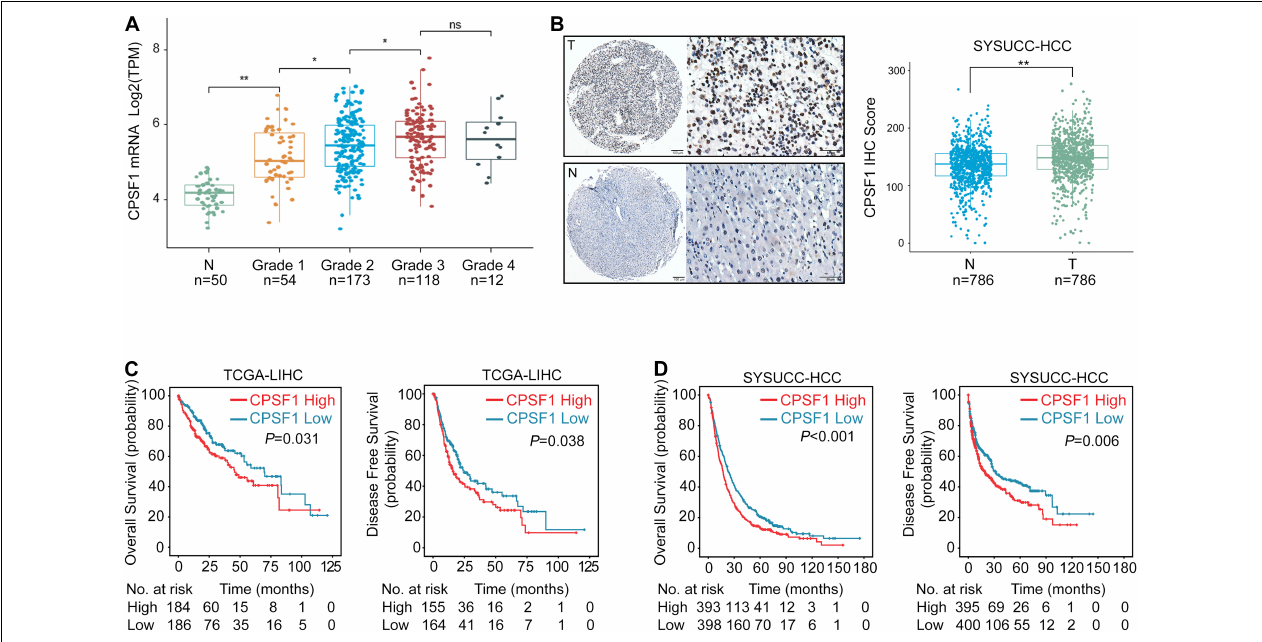
FIGURE 2 | Increased CPSF1 in HCC correlates with unfavorable patient outcome. (A) CPSF1 expression was evaluated in TCGA LIHC samples according to different tumor grades. Two-way ANOVA tests showed statistically significant difference between groups ( P < 2.2e-16). Significant differences between groups were indicated by Student’s t -test in Normal vs. Grade 1 ( P < 0.01), Grade 1 vs. Grade 2 ( P = 0.011), Grade 2 vs. Grade 3 ( P = 0.033), but not in Grade 3 vs. Grade 4 ( P = 0.92). (B) Representative images of IHC staining of CPSF1 in tumor (T), and non-tumor (N) tissues. The IHC score for each case is shown on the right. (C,D) Correlation between CPSF1 expression and overall survival as well as disease-free survival was determined in the TCGA (C) , and SYSUCC cohorts (D) by Kaplan–Meier analysis. The high and low CPSF1 groups were separated based on median mRNA level in TCGA and median IHC score in SYSUCC cohorts. P -values in (C) and (D) were calculated by log-rank tests. ** P < 0.01 and * P <